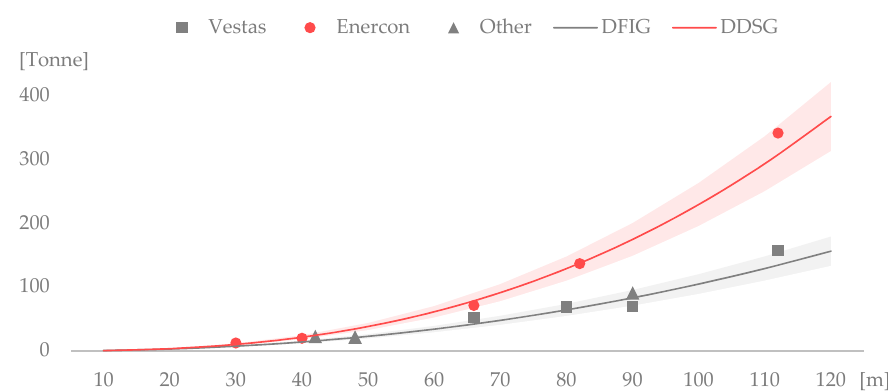
Figure B2. Nacelle mass vs. rotor diameter. The grey line represents the output from Equation (2) (using the values in the mentioned study), and the grey and red markers show actual nacelle masses gathered from LCA’s. The red line shows the output from Equation (2) when using the least square method to fit the variables to turbines of DDSG design.